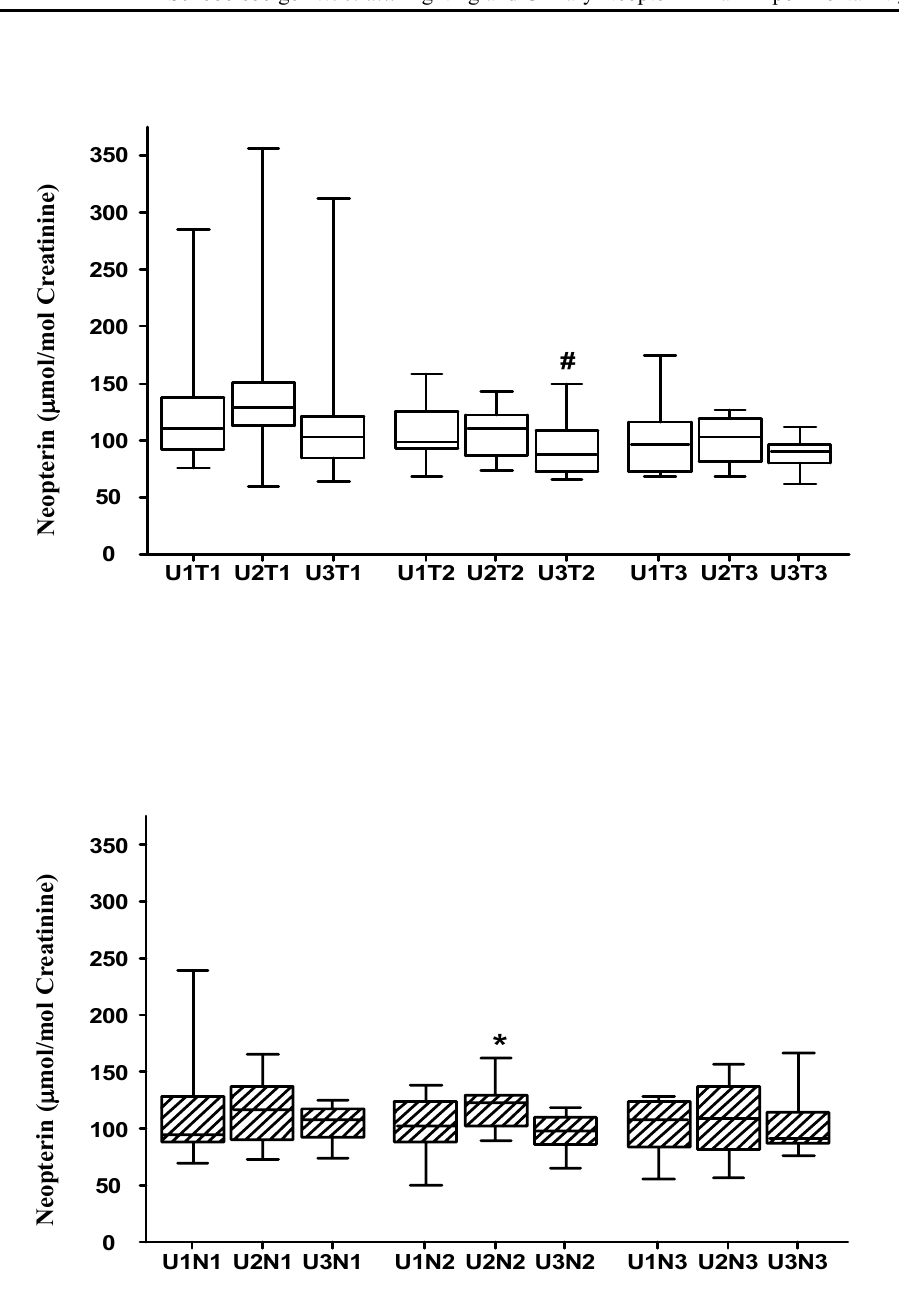
Figure 1. Time course of urinary neopterin concentrations on the first, second, and third night either in a light- ing environment with reduced short-wavelength components (T1, T2, and T3; upper part of Figure 1) or in an unfiltered bright light environment (N1, N2, and N3; lower part of Figure 1). Time points of specimen collection were 22:00 h (U1), 02:00 h (U2), and 06:00 h (U3), respectively. Data are given as median together with the 25 th and the 75 th quartile, whiskers represent highest and lowest values. #P < 0.05 as compared to time point U1 of the respective night of the study; *P < 0.05 as compared to time points U1 and U3 of the respective night of the